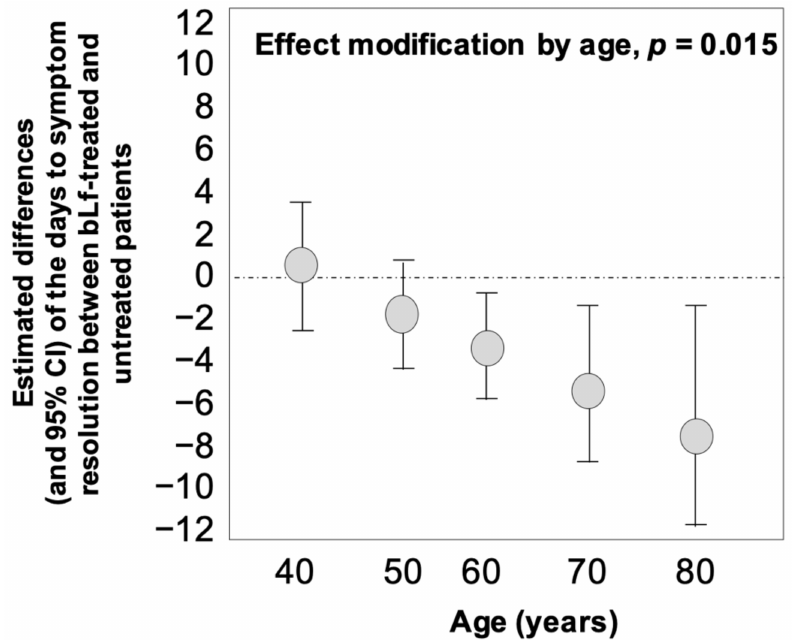
Figure 6. Effect modification by age on the effectiveness of bovine lactoferrin (bLf) in reducing the days to symptom resolution. Data are presented as estimated mean differences and 95% confidence interval